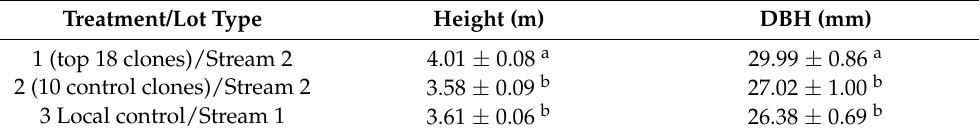
Table 4. Growth data (height and diameter at breast height (DBH)) ( ± SE) of balsam poplar in 2019 for all treatments (top 18 clones from treatment 1 and all clones from treatment 2 and treatment 3). Significant differences between treatment means are indicated by different letters.